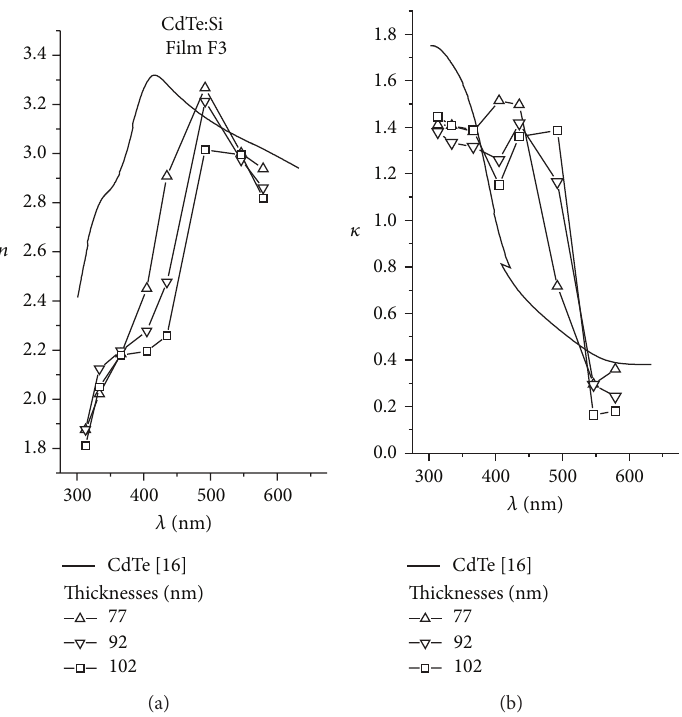
Figure 4: Optical constants spectra for film F3 depending on the film thickness in different